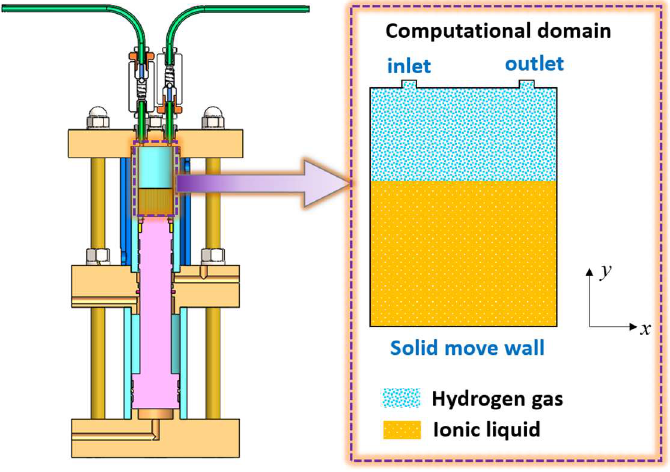
Figure 3. Computational domain in the numerical model.